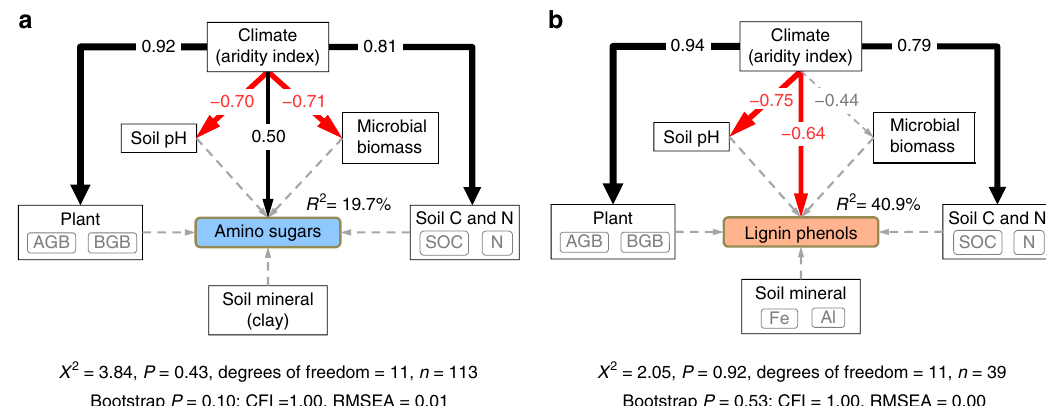
Fig. 5 Cascading relationships of amino sugars and lignin phenols with environmental variables. Best-supported structural equation models disentangling major pathways of environmental in fl uences on the soil organic carbon (SOC)-normalized concentrations of amino sugars ( a ) and lignin phenols ( b ) in the Mongolian grasslands with block effect accounted for. Black and red arrows indicate positive and negative fl ows of causality ( p < 0.05), respectively. Gray dotted lines indicate insigni fi cant pathways from a priori models (Supplementary Fig. 5). Numbers on the arrow indicate signi fi cant standardized path coef fi cients, proportional to the arrow width. R 2 indicates the variance of biomarkers explained by the model. Environmental variables are categorized into plant, soil carbon (C) and nitrogen (N), and soil mineral by a principle component analysis (PCA). Variables in the gray boxes show a positive correlation with the corresponding primary environmental category (Supplementary Table 6). Microbial biomass is represented by phospholipid fatty acids. AGB aboveground biomass, BGB belowground biomass, Fe iron, Al aluminum